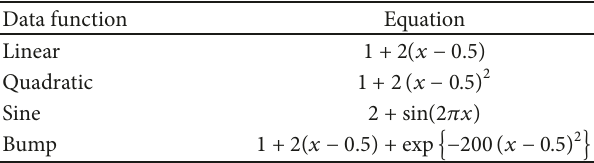
Table 1: Equations of data functions simulated.